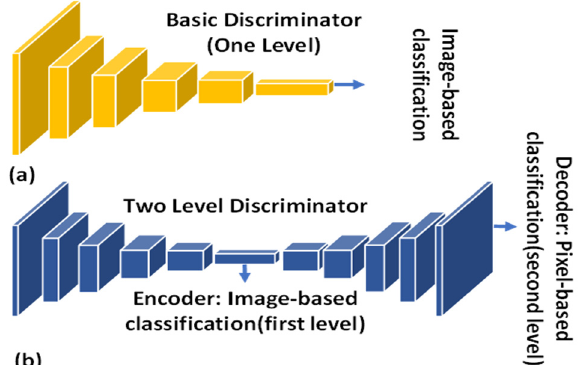
Figure 4. Comparison between the one-level discriminator and two-level discriminator: ( a ) the entire image is classified by the one-level discriminator as either fake or real, whereas ( b ) the two-level discriminator judges both constituent pixels and the whole image.